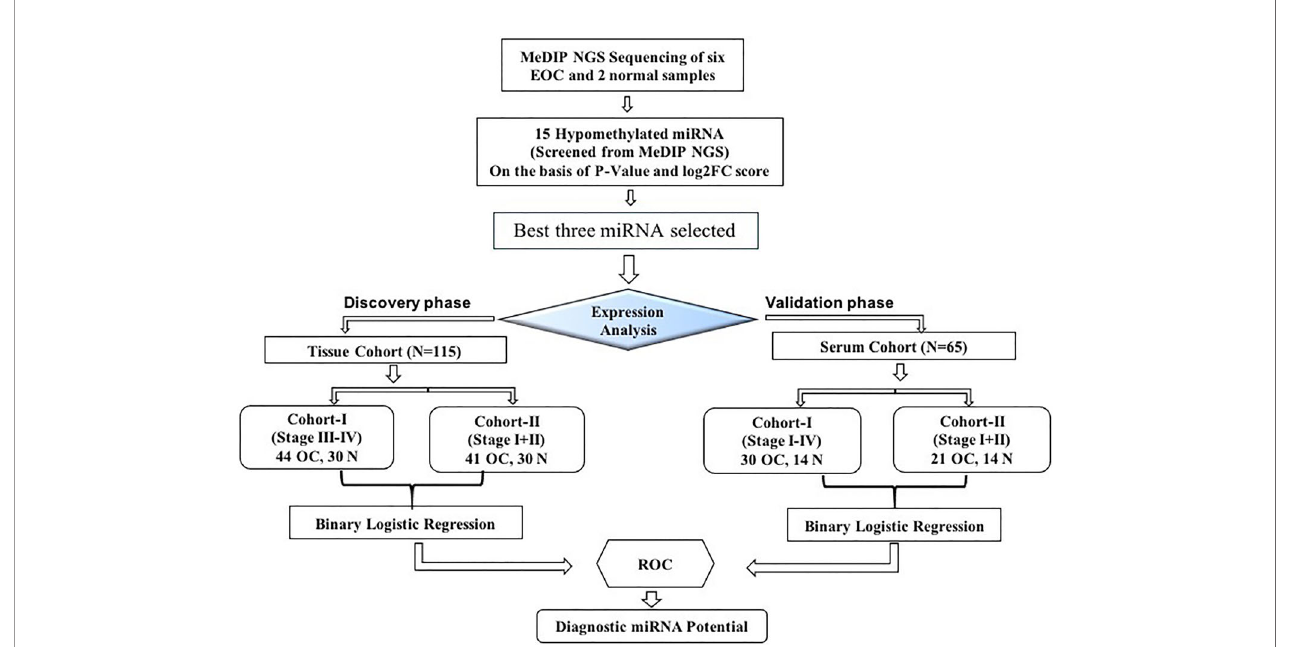
FIGURE 1 | The layout of the study design. MeDIP, methylated DNA immunoprecipitation; EOC, epithelial ovarian cancer; ROC, receiver operating characteristic; N,